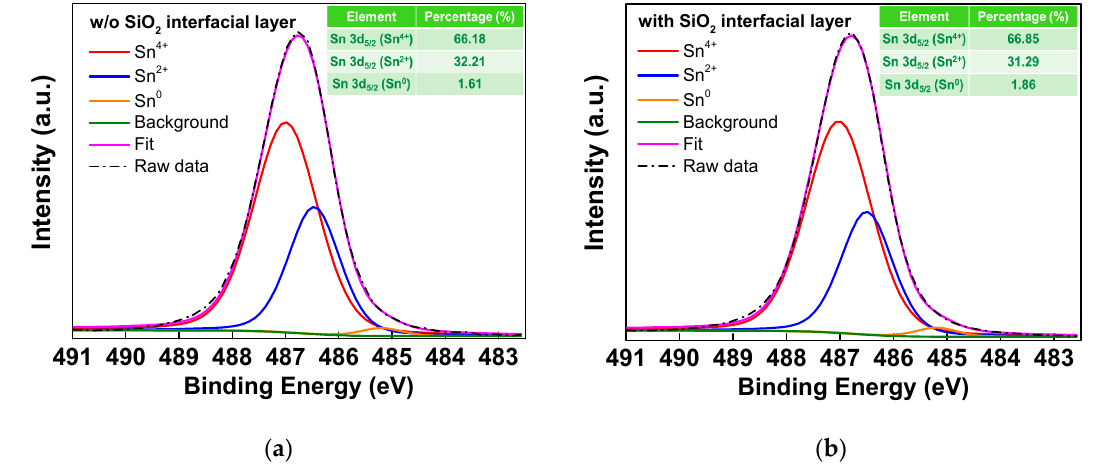
Figure 3. The XPS spectra of Sn 3d 5/2 in the SnO 2 layer of the TFT devices ( a ) without and ( b ) with an SiO 2 interfacial layer.